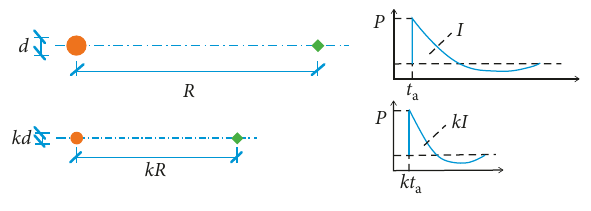
Figure 17: Similarity law of